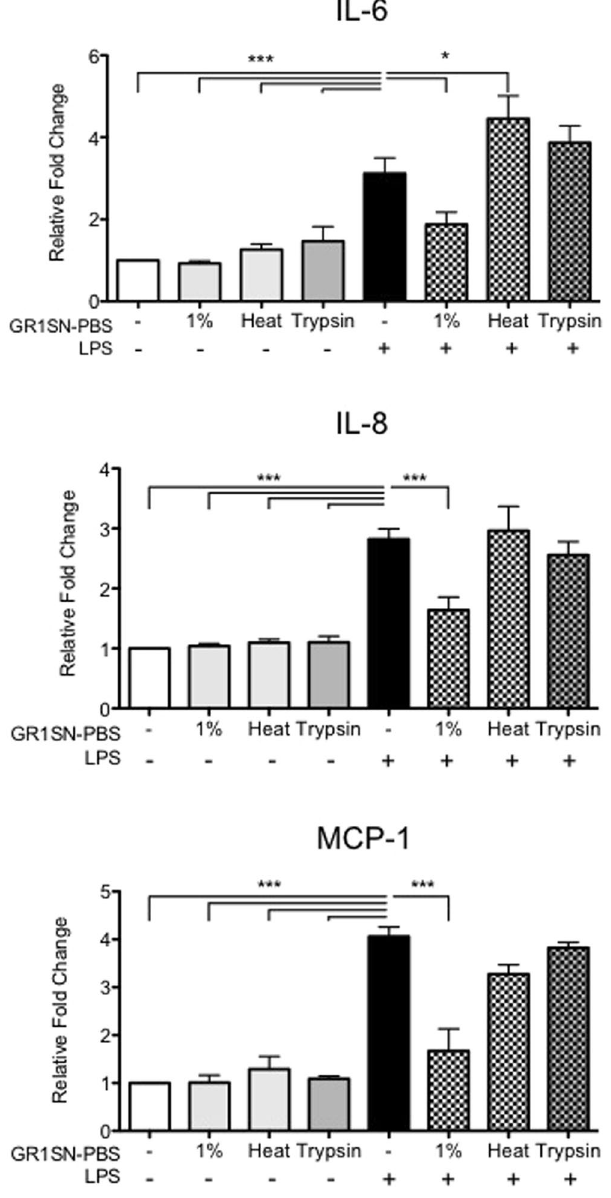
Figure 7. Effect of modified GR1SN-PBS on LPS-induced cytokine secretions. hTERT-HM cells were treated with non-modified GR1SN-PBS (“1%”), or with GR1SN-PBS modified to denature protein structures (“Heat”) or to degrade proteins (“Trypsin”), with (checkered grey bars) or without (solid grey bars) LPS stimulus (100 ng/ mL). Values are presented as fold change (mean ± SEM) relative to untreated cells (white bars). Statistical significance was determined by One-way ANOVA followed by Dunnett’s post-test relative to LPS stimulus (solid black bars). * P < 0.05; ** P < 0.01; *** P < 0.001 (n =